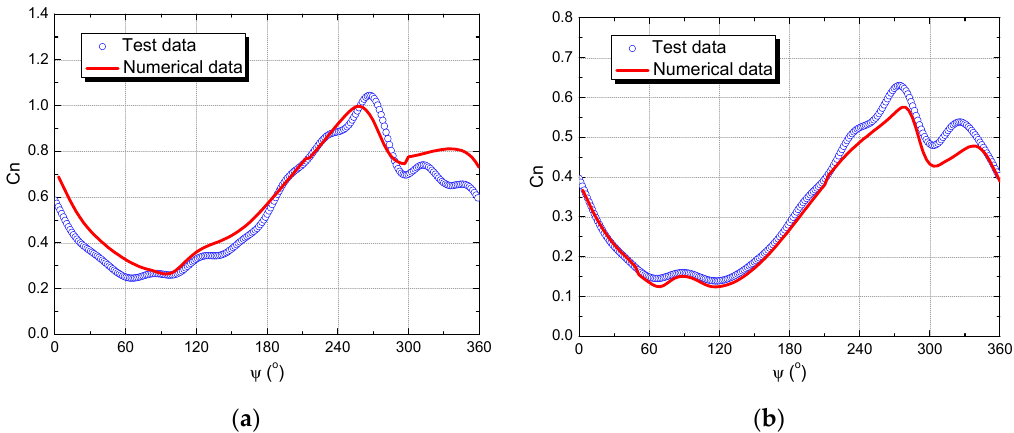
Figure 6. Comparison of normal force between the test data and numerical data. ( a ) r/R = 0.75. ( b ) r/R = 0.97.